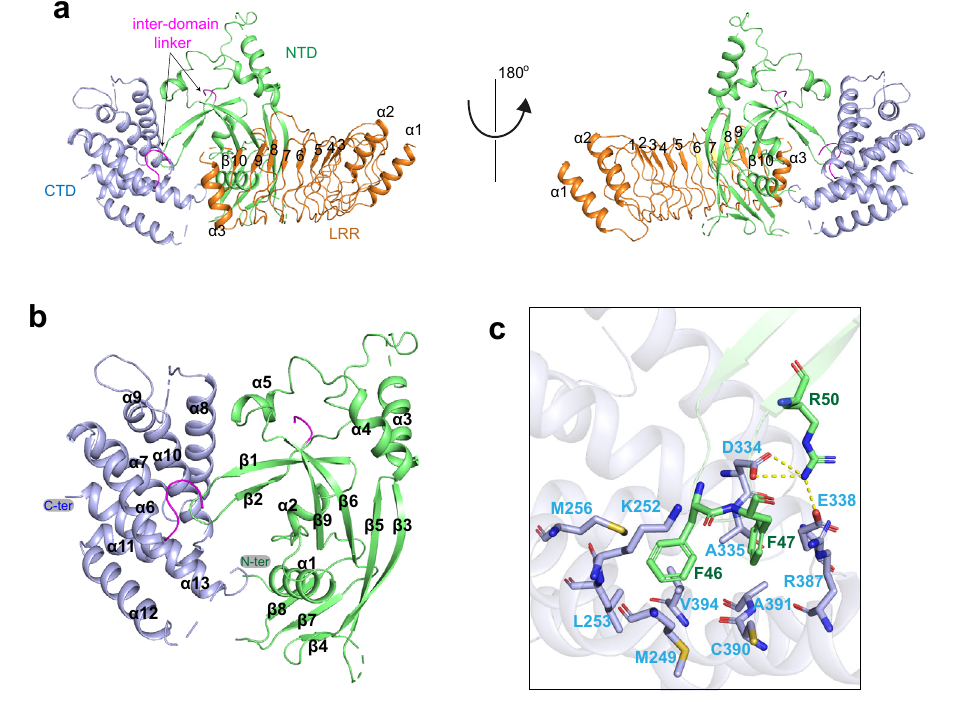
Fig. 2 | Overall structure of GSDMB in complex with LRR domain of IpaH7.8. a CartoonrepresentationoftheGSDMB-LRRstructure.TheLRRunitsareindicated by numbers. The color scheme is the same as in Fig. 1a. b Overall structure of GSDMB.TheNTDandCTDarecoloredgreenandlightblue,respectively.Theinter-